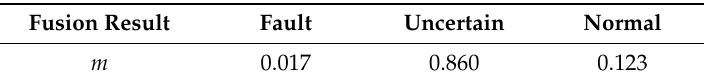
Table 3. The weighted mass functions.